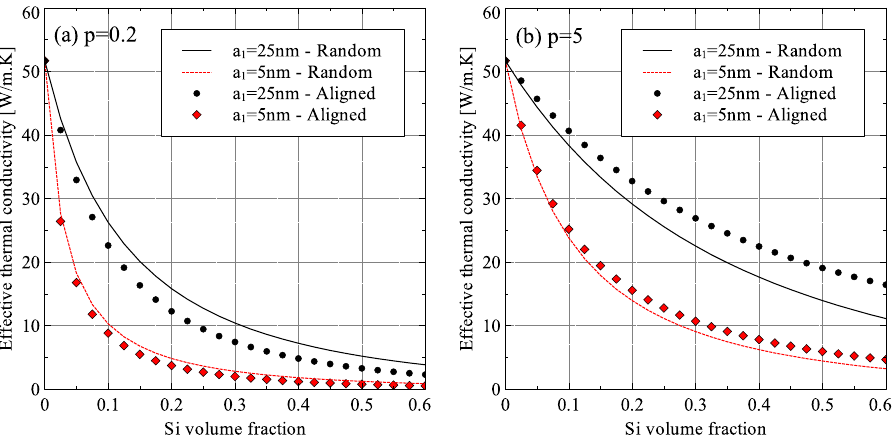
Figure 16. Dependence of Ge–Si effective thermal conductivity on inclusion alignment for inclusion aspect ratio p equal to: ( a ) 0.2; and ( b ) 5 ( R TB = 6.80 × 10 − 9 m 2